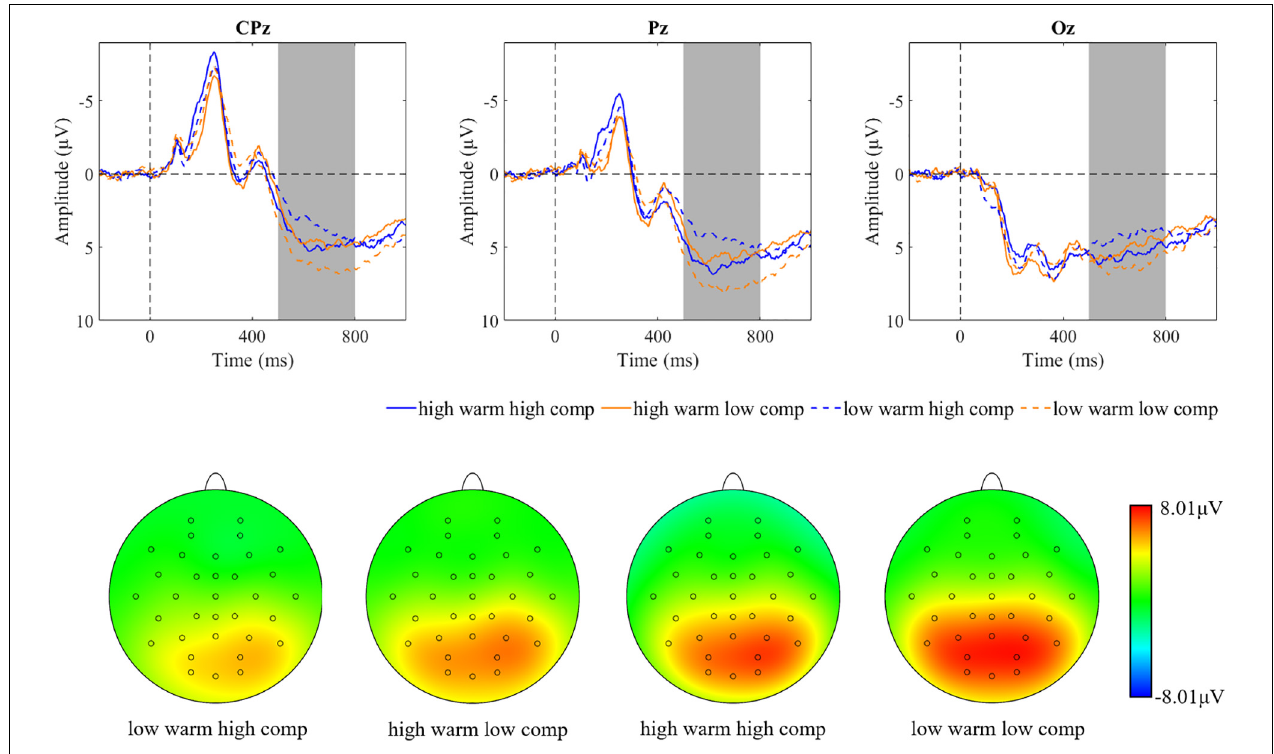
FIGURE 10 | Brainwaves and scalp topographies of the LPP activity for four